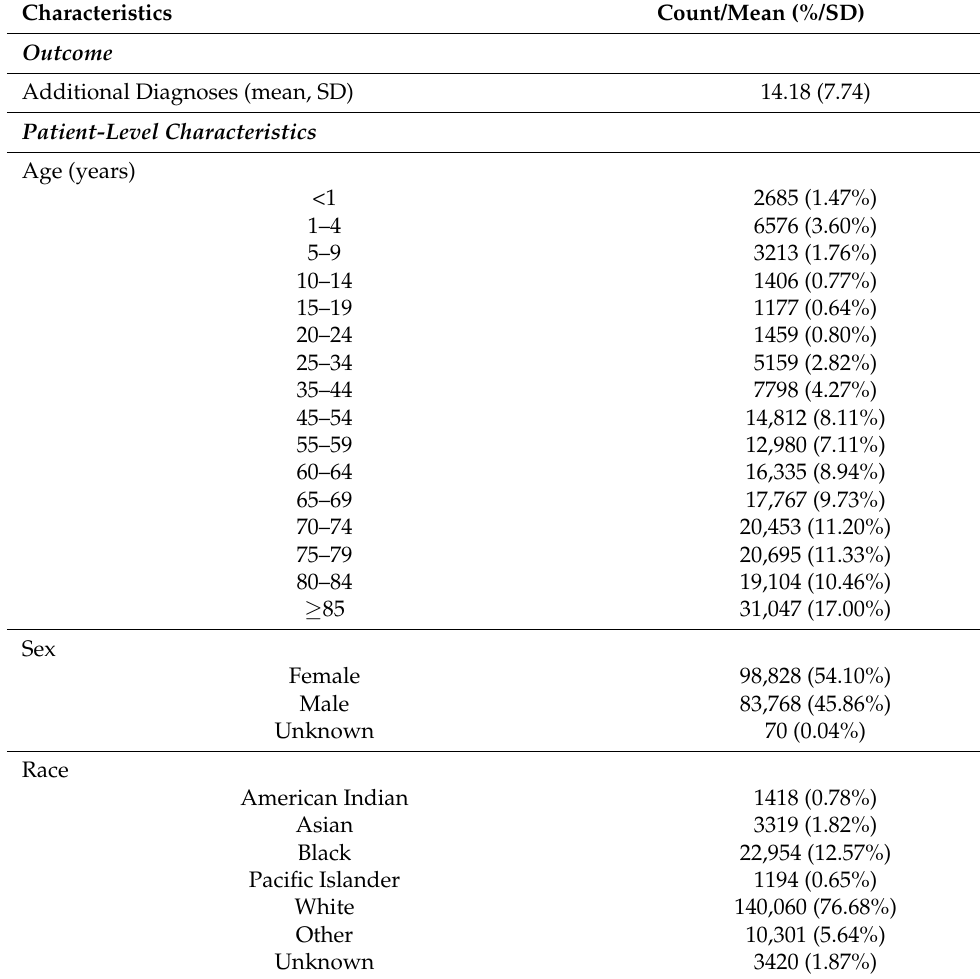
Table 1. Summary statistics of patient-level and facility-level